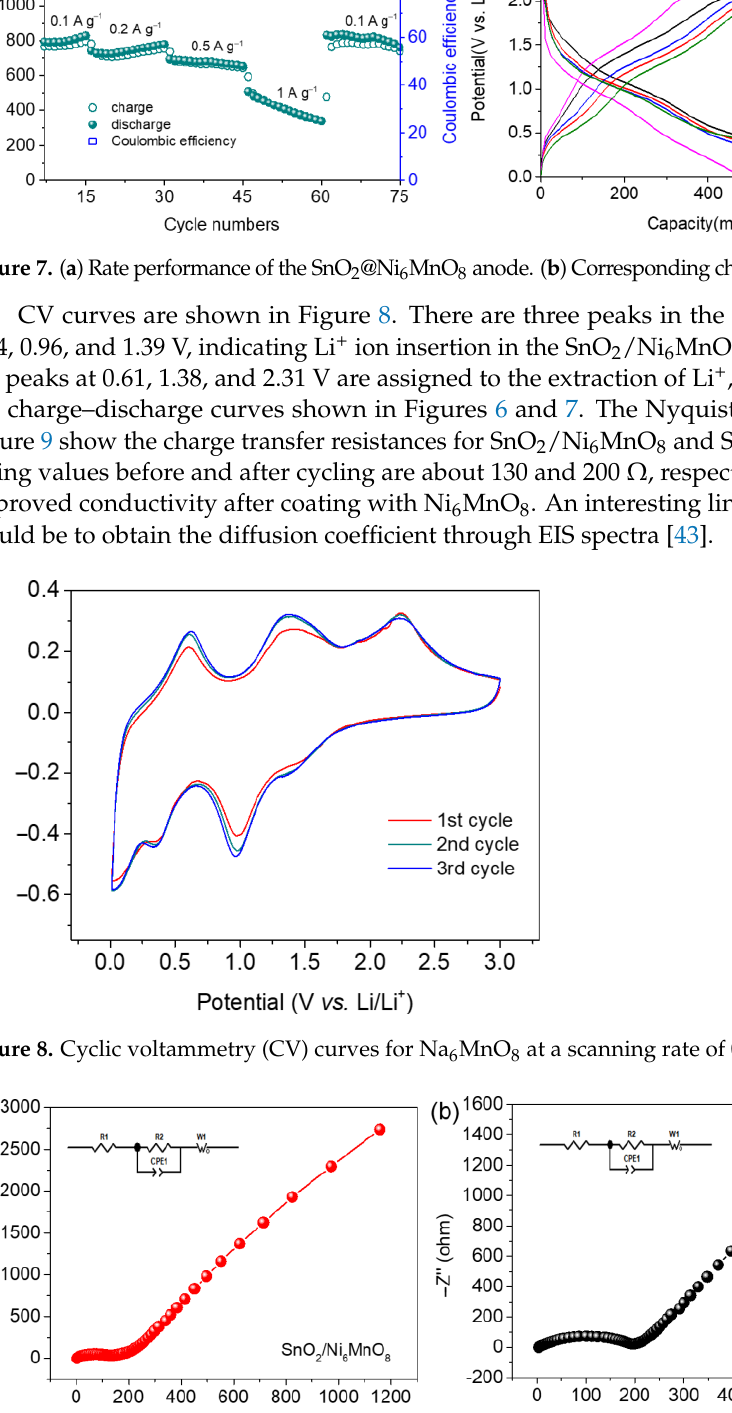
Figure 9. Nyquist plots for the ( a ) SnO 2 /Ni 6 MnO 8 and ( b ) SnO 2 /C anodes.